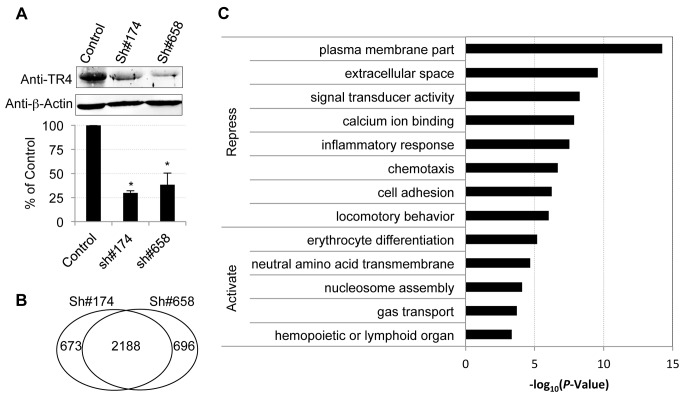
Characterization of TR4 downstream targets with lentiviral-mediated shRNAs.(A) The upper panel shows the immunoblots of TR4 and β-actin (internal control) in shRNA lentivirus (#174 and #658) or control virus infected cells at D11. The bar graph shows the relative abundance of TR4 normalized to β-actin and to control cells (*p<0.05 and error bars represent s.e.m.). (B) Venn diagram summarizing the common and unique differentially expressed genes after TR4 depletion with lentivirus sh#174 and sh#658. (C) The enriched GO terms for TR4 repressed and activated genes, respectively.